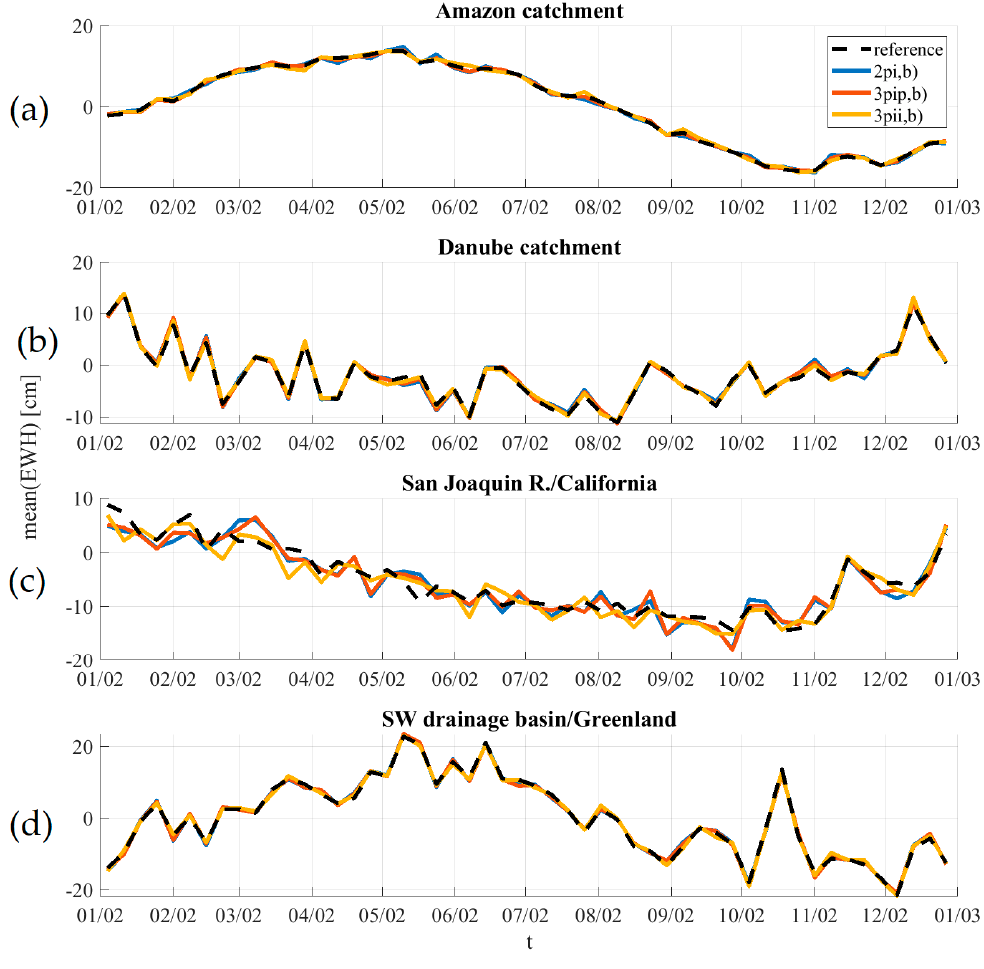
Figure 11. Time series for four selected catchments in EWH (cm) ( a ) Amazon basin, ( b ) Danube basin, ( c ) San Joaquin River / California, ( d ) South-East drainage basin / Greenland extracted from seven-day solutions up to d / o 50 based on scenario 2pi, 3pip,b, and 3pii,b. Compare to Table 7. Daily Wiese solution co-parametrized up to d / o 15. Table 7. Standard deviation of Scenario 2pi, 3pip,b, and 3pii,b up d/o 50 (with daily d/o 15) and the gain of the triple-pair scenarios compared to the double pair scenario. Computed over one year of the indicated catchments in cm EWH. Clustered: Big catchments, small catchments, ice drainage basins according to the Rignot basins, IMBIE project (http://imbie.org/imbie-2016/drainage-basins/). Additionally, in the last two columns are the standard deviation of daily solutions based on Scenario 3pii,b, once co-estimated up to d/o 15 and once co-estimated up to d/o 25.